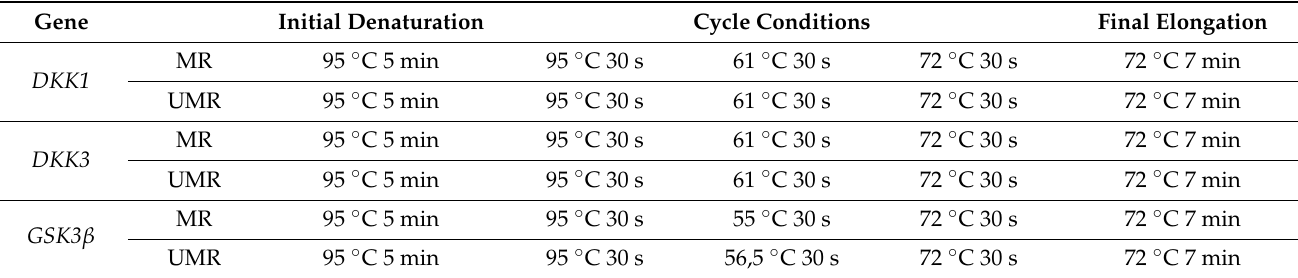
Table 2. MSP conditions for amplification of promoter region of DKK1 , DKK3 , and GSK3 β